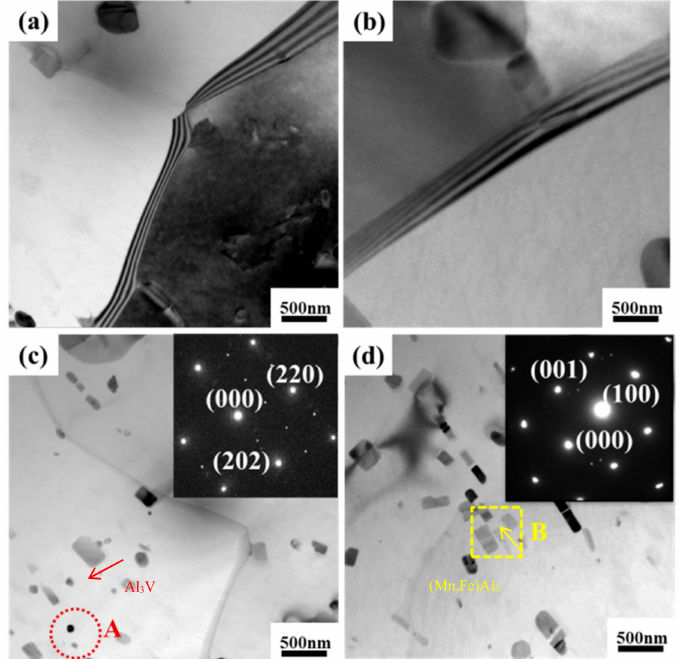
Figure 3. TEM bright field images of the homogenized aluminum alloys: ( a ) 5083, ( b ) 5083 + 0.03 wt.% V, ( c ) 5083 + 0.05 wt.% V and ( d ) 5083 + 0.10 wt.%